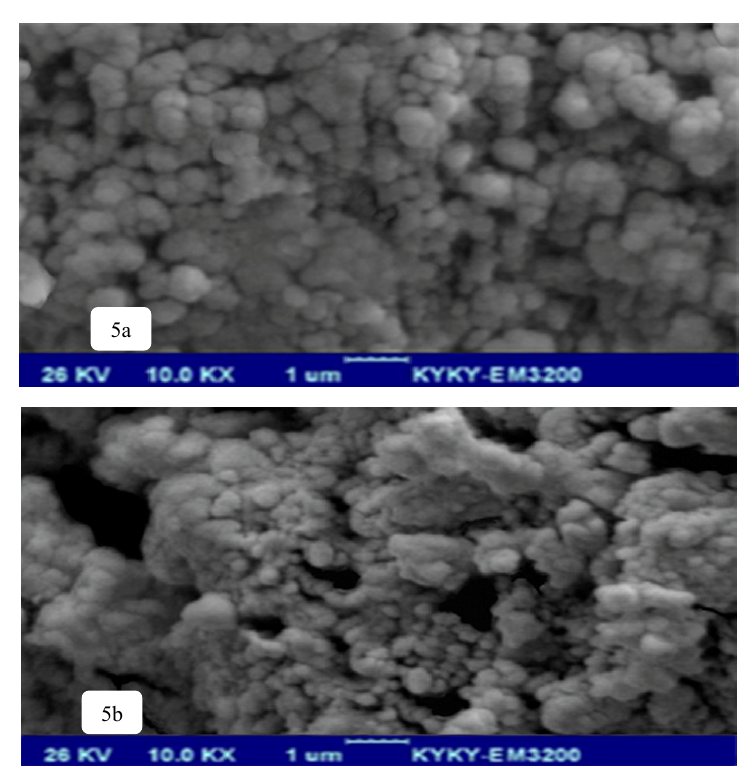
Fig. 5. FESEM images of FZ-2 and FZ-3